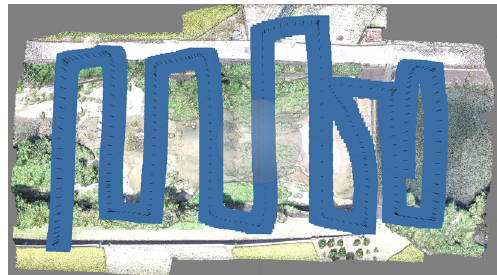
Figure 6. Point cloud data and camera position 4.3 Accuracy Validation of Point Cloud Data